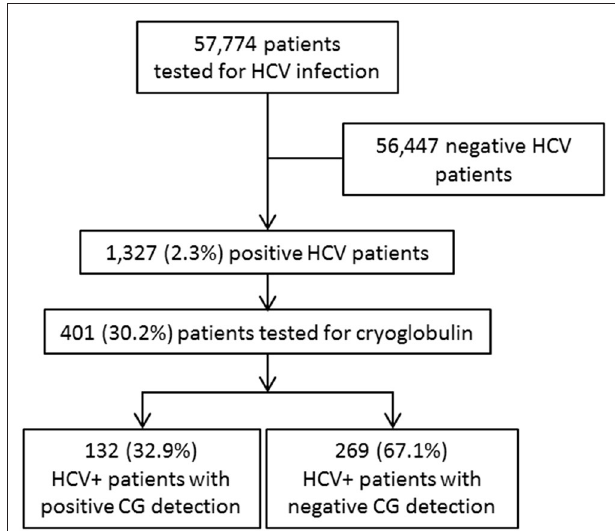
FIGURE 2 | Hepatitis C virus infection determination and CG